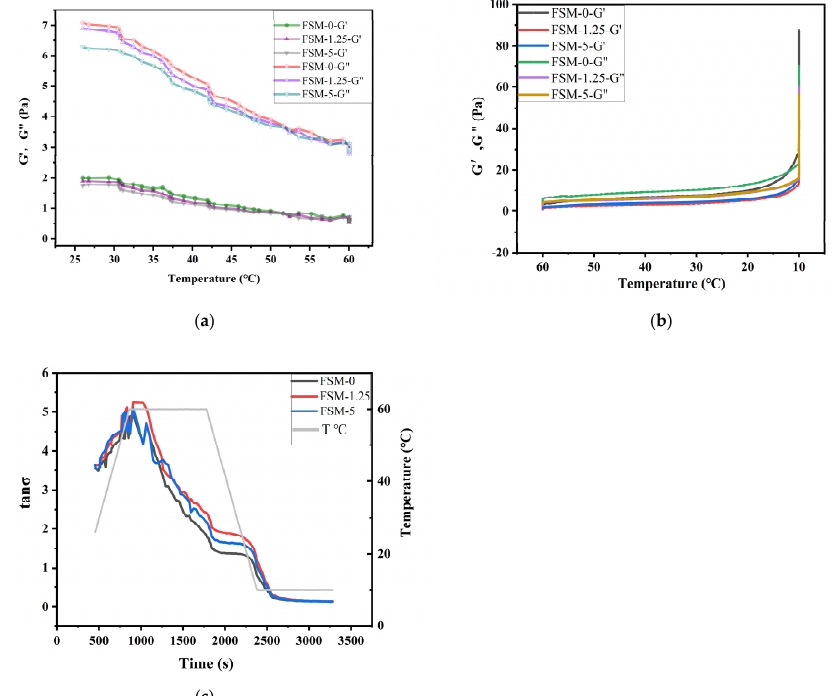
Figure 4. Temperature sweep curves of composite films: ( a ) Changes in storage modulus G ′ and loss modulus G ″ during heating regime; ( b ) Changes in G ′ and G ″ during cooling regime; ( c ) Changes in tan δ values in the temperature sweep process.